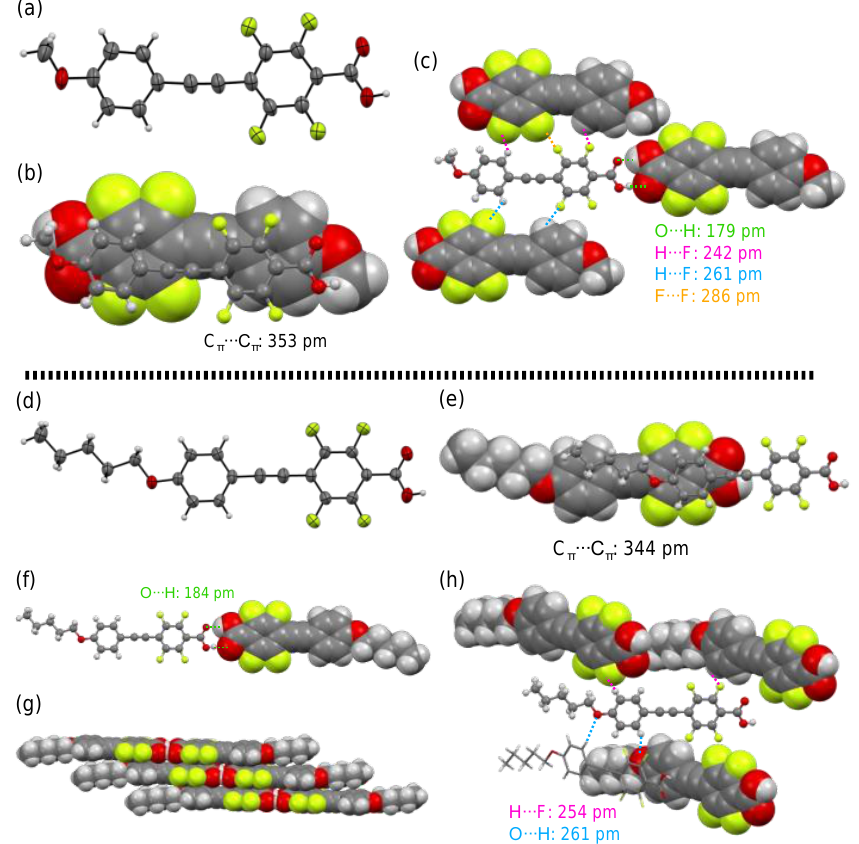
Figure 4. ( a ) Crystal structure of 1a with an ORTEP drawing and ( b , c ) packing structures. ( d ) Crystal structure of 1e with an ORTEP drawing and ( e – h ) packing structures.